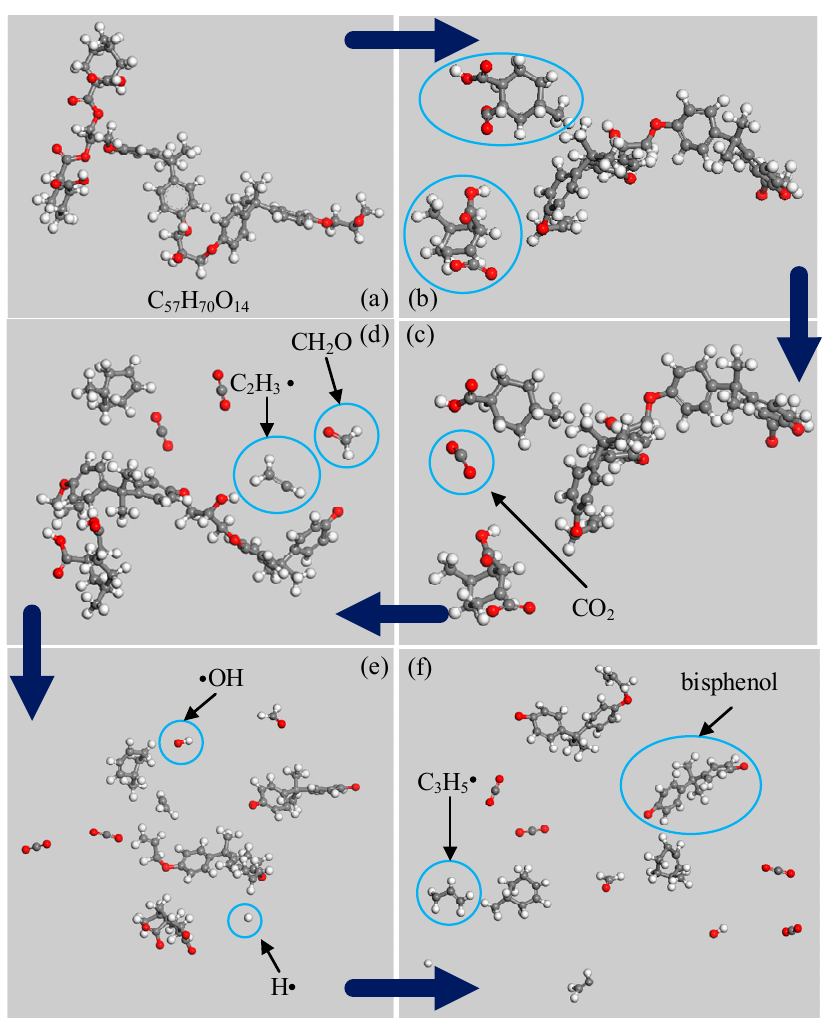
Figure 4. Decomposition process of EPMHA. ( a ) The first decomposition; ( b ) The second decomposition process; ( c ) The third decomposition process; ( d ) the forth decomposition process; ( e ) The fifth decomposition process; ( f ) The sixth decomposition process.